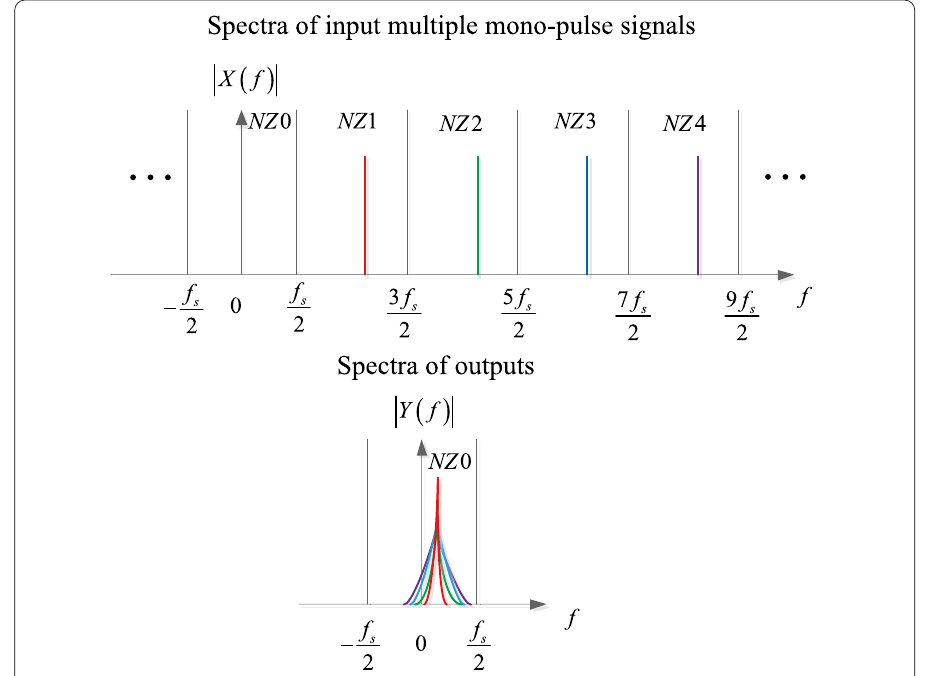
Fig. 2 Multiple mono-pulse signals receiving process based on modulated sampling